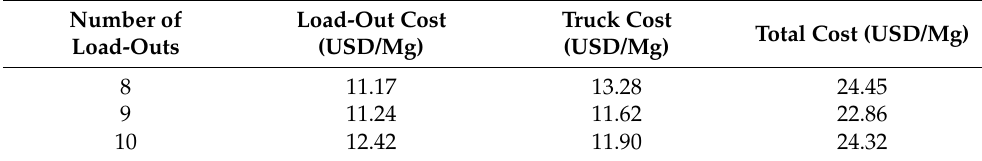
Table 9. Average cost for the delivery of feedstock (USD/Mg annual capacity) based on load-out cost (Table 6) and truck cost (Table